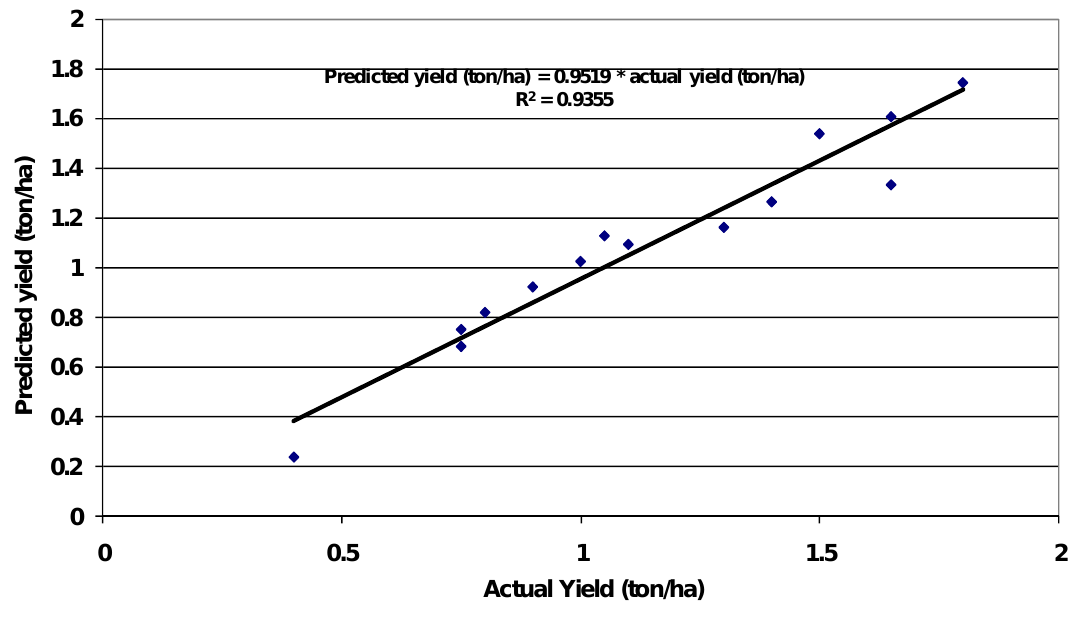
Figure 14. The model was validated using yield data from an independent study [63].